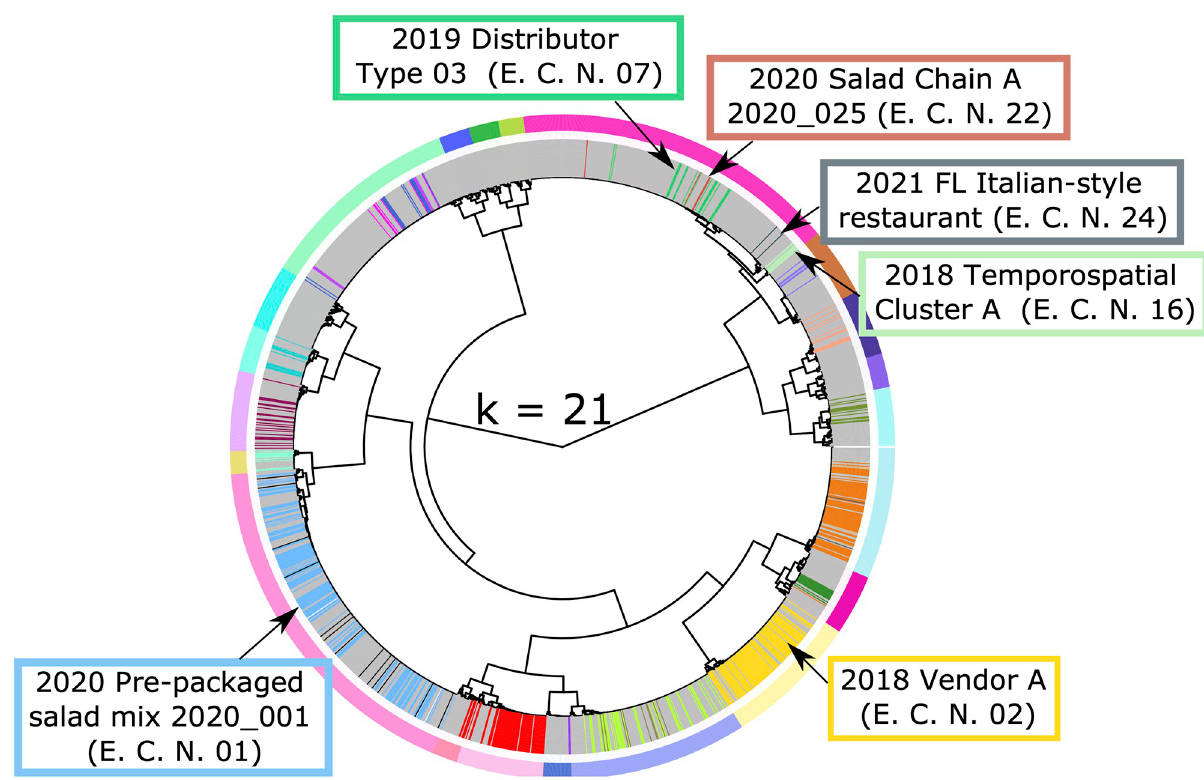
Fig 1. Impact of minimum stringency ( s ) value on genetic linking of epidemiologically-linked isolates. The hierarchical tree generated from our distance matrix was dissected into the minimum value of k ( k = 21) predicted using the 94% s -value. The outer circle of colored bars indicates the boundary between each partition predicted and the inner circle of colored bars represents the epidemiologic linkage of various isolates, where each bar color represents a distinct epidemiologic cluster (grey represents isolates of unknown epidemiologic linkage). Epidemiological clusters of interest are labeled in the colored boxes. (A) At k = 21, we observe that the labeled epidemiologic clusters on the top right of the tree all belong to a single genetic partition, indicating that different epidemiologic clusters are being unnecessarily grouped into a single genetic partition.